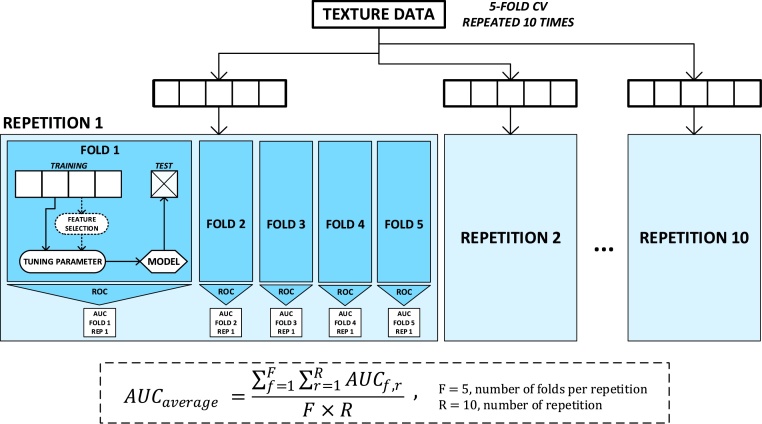
Cross-validation structure used to evaluate the 90 texture datasets. All the samples of each texture dataset were randomly separated R = 10 times in F = 5 folds to evaluate the model with the averaged AUC. This process was repeated for the two models studied (SVM with linear kernel and RF) and for all the chosen tuning parameters. The feature selection process was only applied to those sets which provided the best results to examine the influence of the number of features used to train the model.